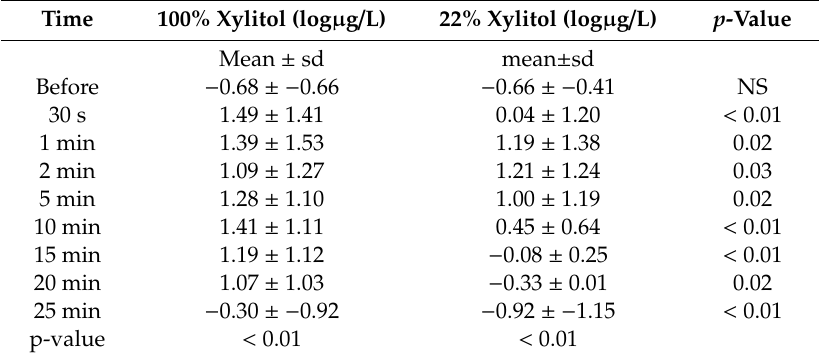
Table 2. Xylitol concentrations in saliva ( µ g / L). One-way ANOVA for the comparison between the two types of chewing gum and two-way ANOVA for intra-group comparison. The values in bold are the maximum peaks